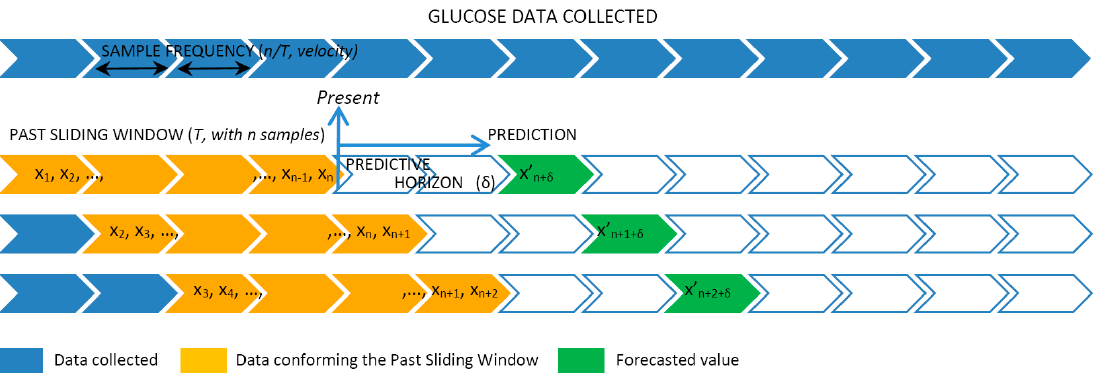
Figure 1. Time series analysis and cross-validation with slide-window.